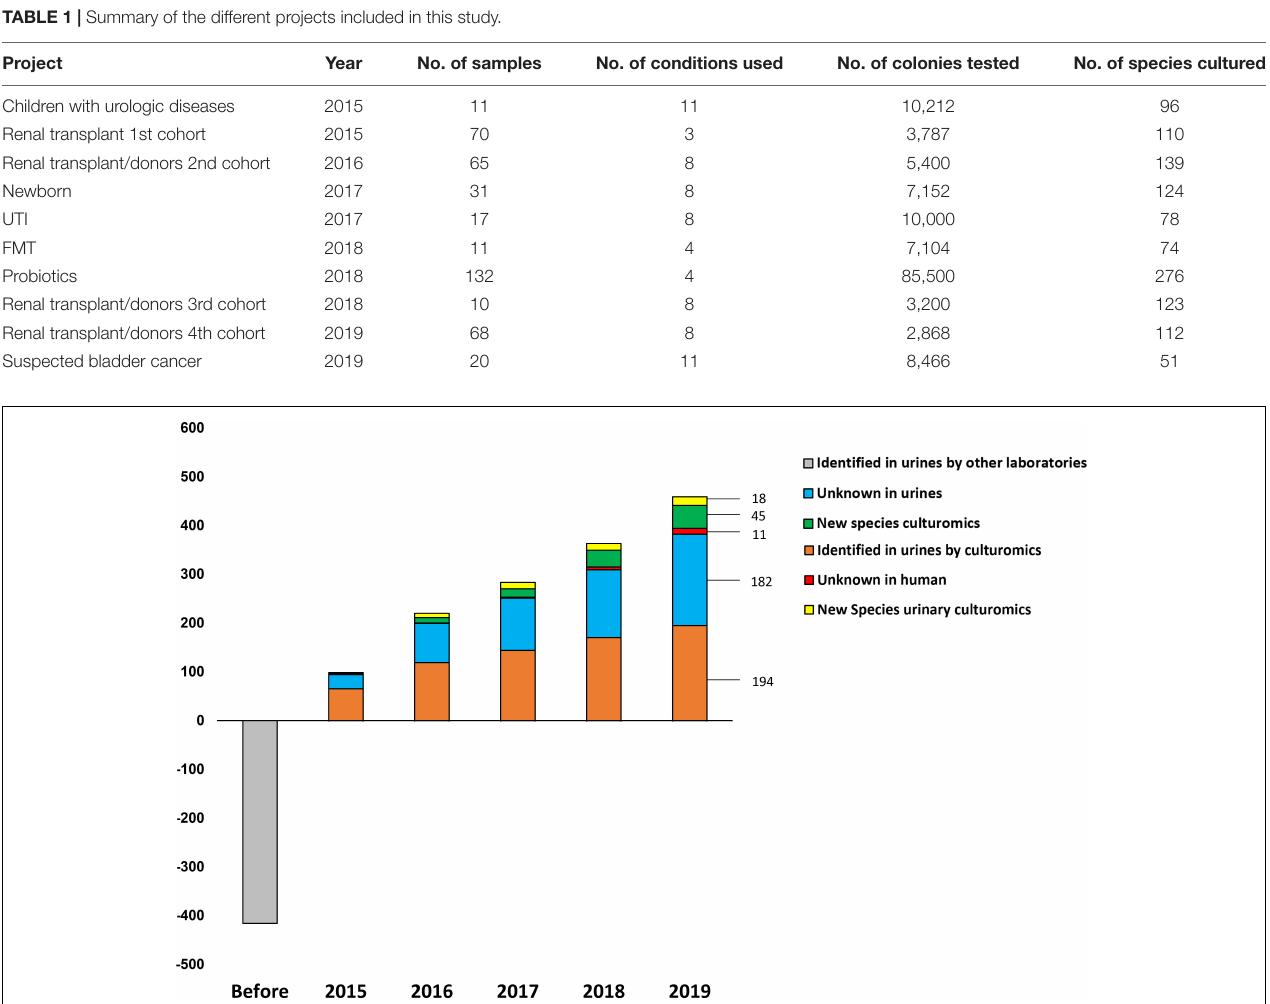
FIGURE 1 | Evolution over time of the urinary repertoire according to culturomics studies. The bacterial species are represented in five categories: Known in urines, prokaryotes isolated by other laboratories but not by culturomics; identified in urines by culturomics, taxa recovered by culturomics studies and already known to belong to the bacterial urinary repertoire; new species culturomics, new taxa discovered as a part of other culturomics studies; unknown in humans, prokaryotes first isolated in humans; and new species culturomics urines, species isolated from urinary tract as a part of this